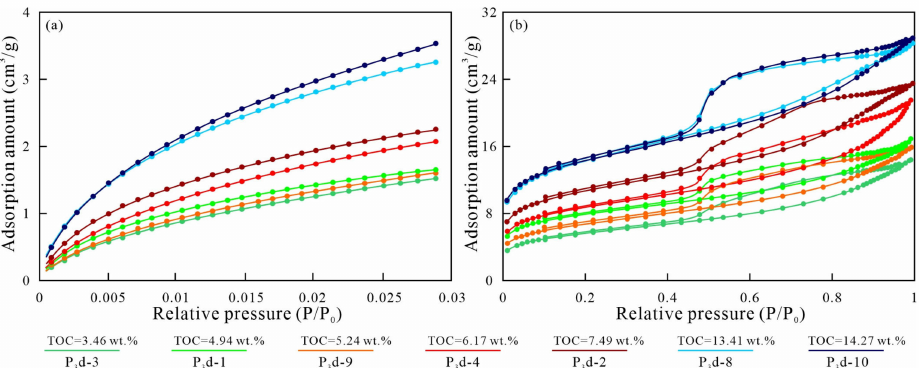
Figure 10. ( a ) CO 2 ( b ) N 2 adsorption-desorption isotherms of Dalong Formation shale samples from well ED-2.